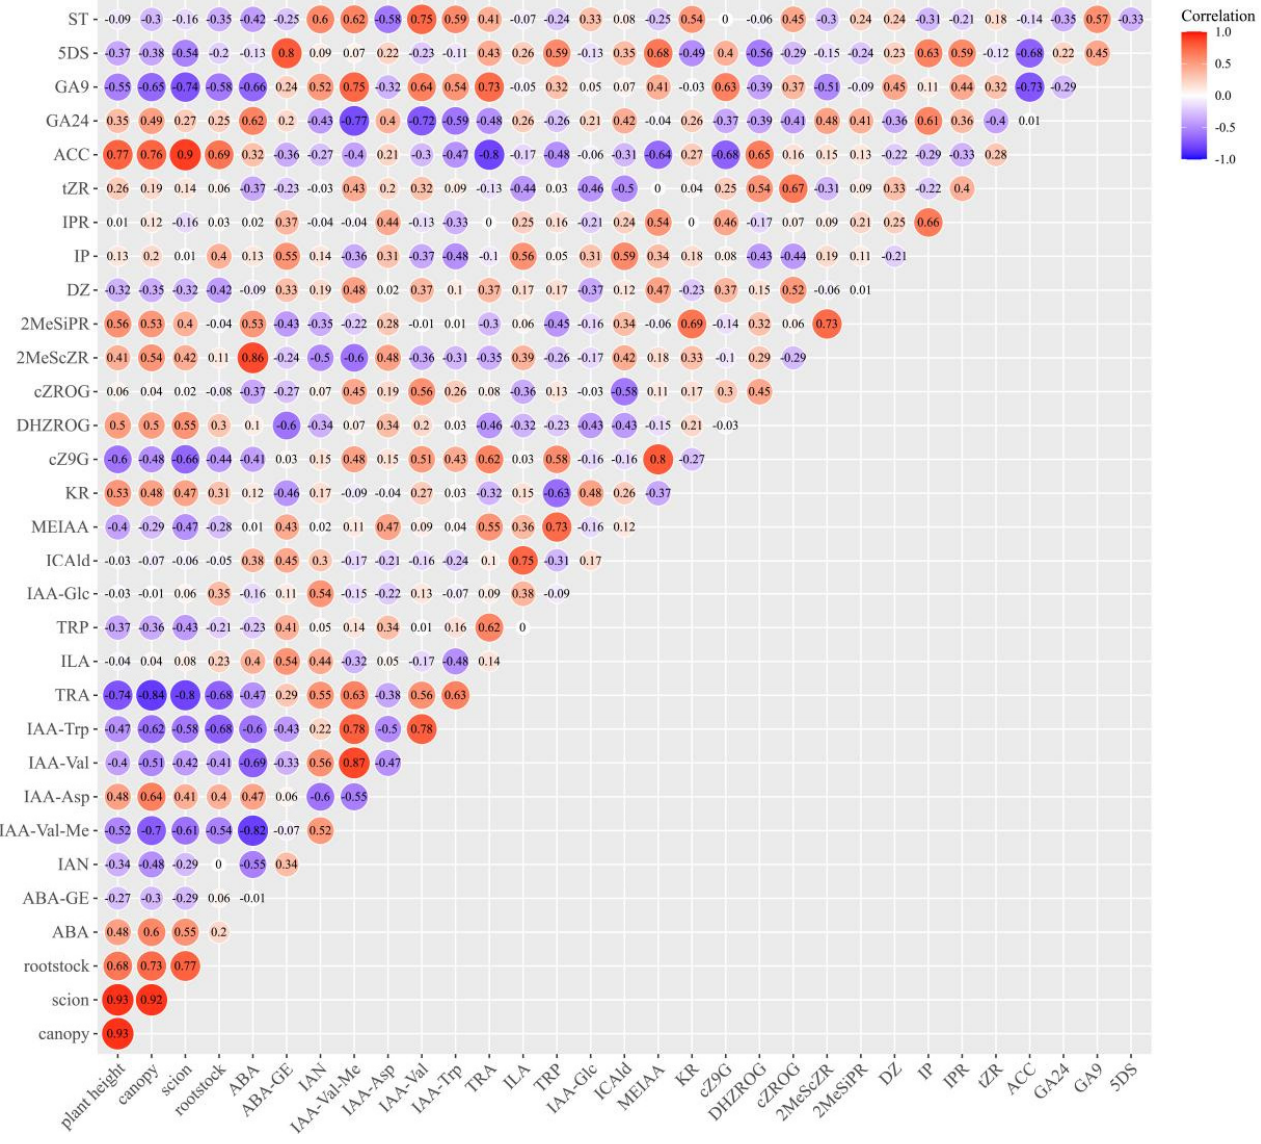
Figure 6. Correlations of the morphological traits and hormone concentrations of ‘Shatangju’ scion cultivar grafted onto different rootstocks. Arbitrations: ABA = Abscisic acid, ABA-GE = ABA glu − cose ester, IAN = Indole-3-acetonitrile, IAA-Val-Me = indole-3-acetyl-L-valine methyl ester, IAA-Asp = Indole-3-acetyl-aspartate, IAA-VAL = Indole-3-acetyl-L-valine, TRA = tryptamine, In- dole-3-lactic acid (ILA), TRP = tryptophan (Trp), IAA-Glc = IAA-glucose, indole-3-carboxaldehyde (ICAld), MEIAA: methyl indole-3-acetate, cZ9G = cis-zeatin N9-glucoside, DHZROG = dihydroze- atin-O-glucoside riboside, cZROG = cis-zeatin-O-glucoside riboside, 2MeScZR = 2-methylthio-cis- zeatin riboside, 2MeSiPR = 2methylthio-isopentenyladenosine, DZ = dihydroze-atin, IP = sopentenyl adenine, IPR = Isopentenyl adenine riboside, tZR = Trans − zeatin ri-boside, ACC = 1-aminocyclopro- panecarboxylic acid, ACC), 5DS = 5-deoxystrigol. 3.6. Expression, Correlation, and PCA Analysis of Differential Metabolites Custer analysis was performed to understand the distinct expression pattern of iden- tified metabolites between these two groups (Figure 7A). To reveal the relationship be- tween various metabolite classes, a correlation analysis was performed based on the ac- cumulation pattern of identified metabolites (Figure 7B), showing they are closely related to each other, might have similar chemical structures, or might take part in metabolic pathways. To examine the natural variations of metabolic traits among different types of cultivars, the principal component analysis (PCA) and partial least squares discriminant